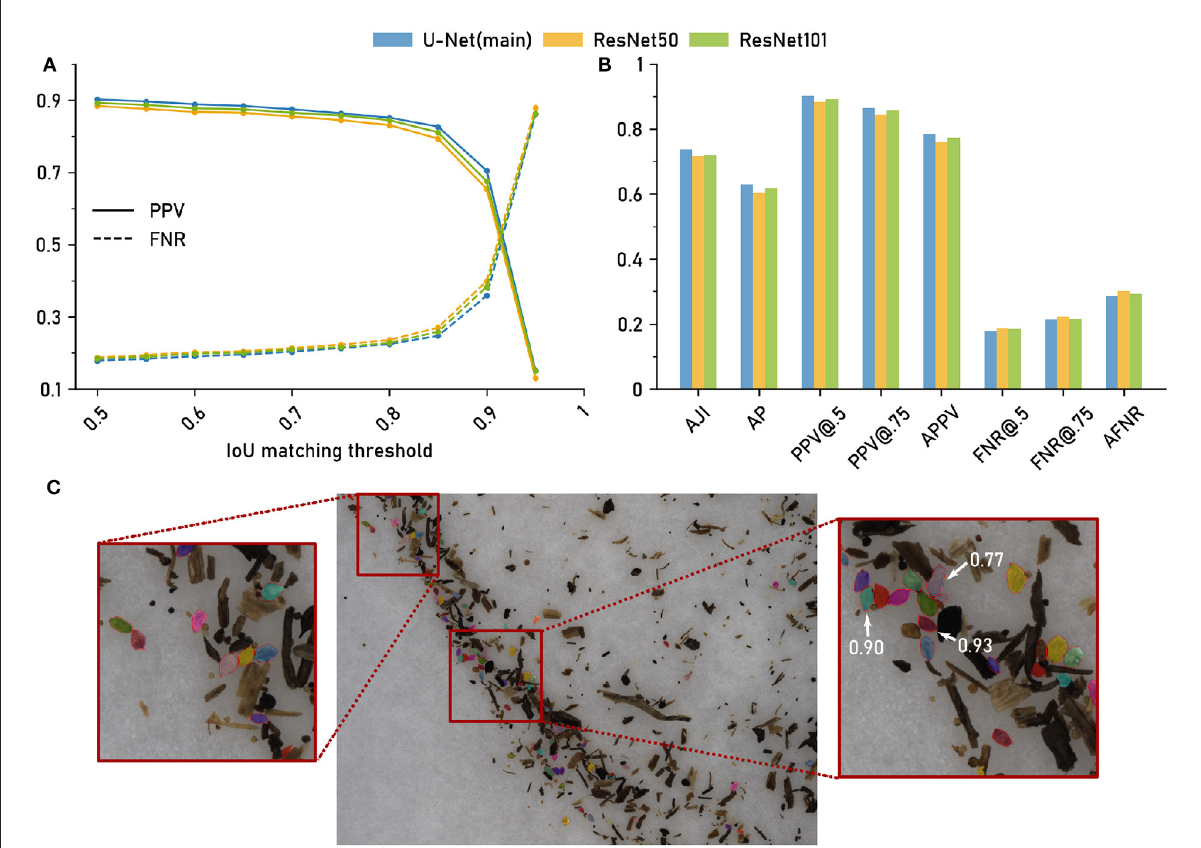
FIGURE3 The computer vision pipeline produces accurate cyst segmentations: Comparison with a manually segmented ground truth. Data set: Cyst-Segmentation . (A) Positive Predictive Value (PPV) and False Negative Rate (FNR) for a range of Intersection over Union (IoU) thresholds. (B) Segmentation quality measures (Methods) for the computer vision pipeline with a U-Net backbone and for two architectural variants (ResNet50 and ResNet101 backbone): Aggregated Jaccard Index (AJI), Average Precision (AP), PPV at different IoU thresholds, Average PPV (APPV), FNR at different IoU thresholds, Average FNR (AFNR). (C) Qualitative examples for cyst segmentation masks (U-Net). Red lines mark the ground truth boundaries. Selected instance masks are annotated with IoU